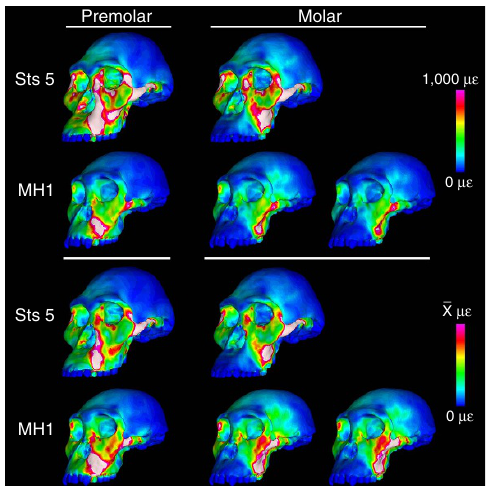
Figure 2 | Colour mapping of von Mises strain in finite element models of Sts 5 ( A. africanus ) and MH1 ( A. sediba ) crania during simulated left premolar (P 3 ) and left molar (M 2 ) biting (not to scale). Colour maps on the top half of the figure reflect absolute strain magnitudes ranging from 0 to 1,000 microstrain ( me ), where white regions experience strain magnitudes that exceed 1,000 me . Colour maps on the bottom half of the figures reflect relative strain magnitudes where the colour scale of each model ranges from 0 to a value equal to twice the average of strain magnitudes collected from 10 standard locations from which strain data have been collected during in vivo feeding experiments in primates 29 . These relative strain maps provide information about the distribution of relatively high and relatively low strain concentrations independent of the scale of the strain magnitudes. For the molar biting analysis, it was necessary to rerun the model of MH1 with the balancing (non-biting) side muscle forces reduced by nearly 30% in order to remove a distractive (tensile) reaction force at the working (biting) side jaw joint. Therefore, under the column for molar biting, the model of MH1 is shown loaded with bilaterally symmetrical muscle forces (left), as well as with asymmetrical muscle forces (right).